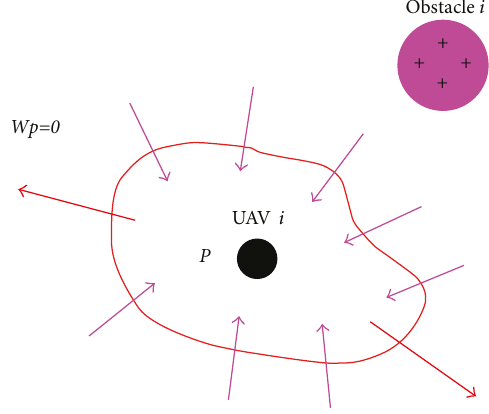
Figure 6: No local minima in fl ux-conserved force fi eld.